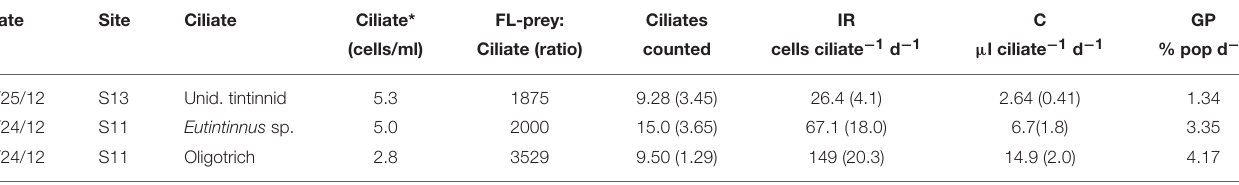
TABLE 5 | Grazing rates of heterotrophic ciliates in the Choptank River on fluorescently labeled (FL) Teleaulax amphioxeia